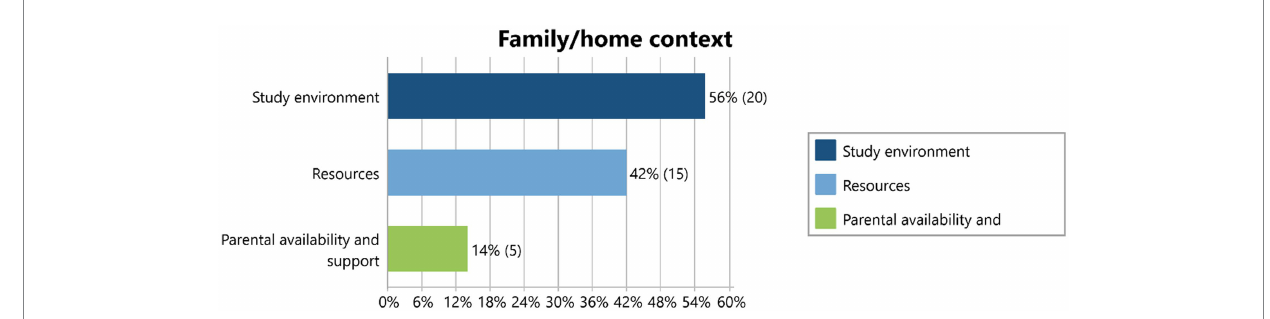
FIGURE 7 Frequency of documents referring to the subcategory Family/home context, within the category Children’s constraints.